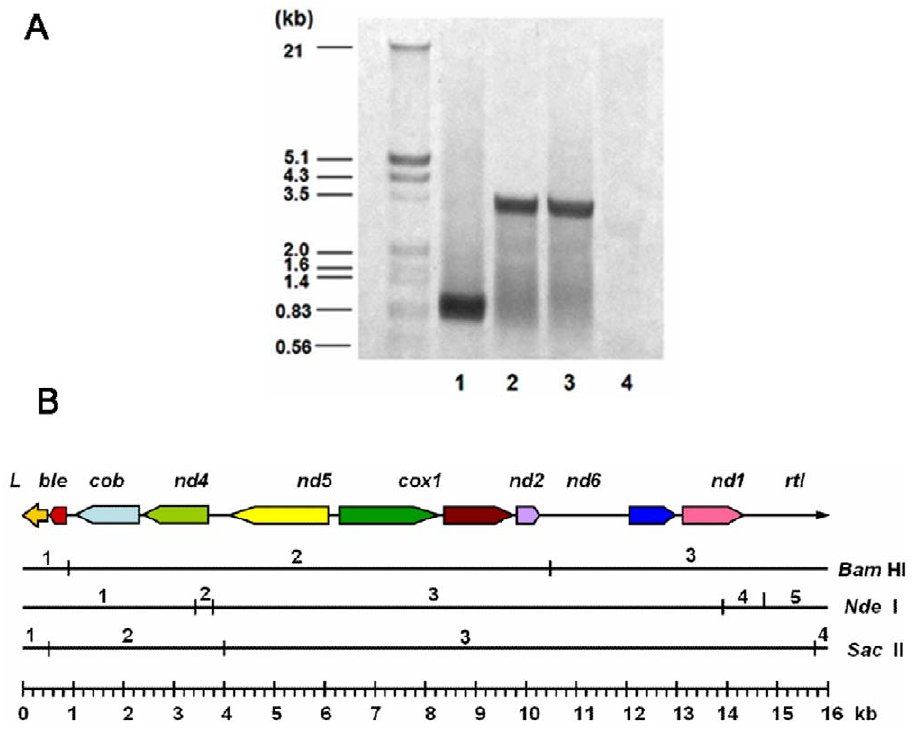
Figure 3. Analysis of the Shble gene integrated site in the mitochondrial genome of MT-B. A: The Southern hybridization of C. reinhardtii MT-B with the ble-probe; B: Restriction map of the mitochondrial genome of C. reinhardtii MT-B showing the positions of all mapped genes and restriction sites. Line 1,2, 3: Total DNA of MT-B were digested with Bam HI, Nde I and Sac II, respectively, Line 4: the genome of CC-2654 digested with Nde I was used as